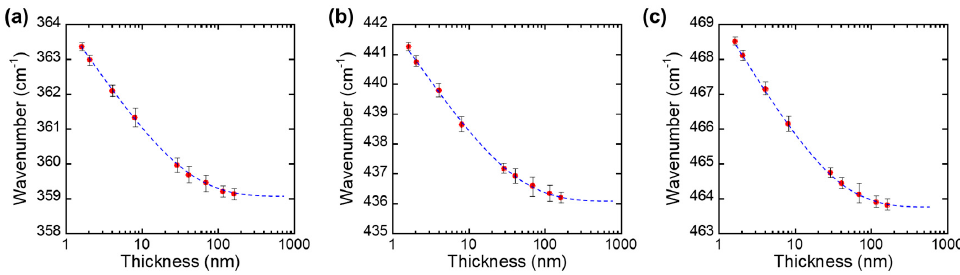
Figure 4. Peaks of ( a ) A g1 , ( b ) B 2g , and ( c ) A 2g Raman modes as a function of their thickness.